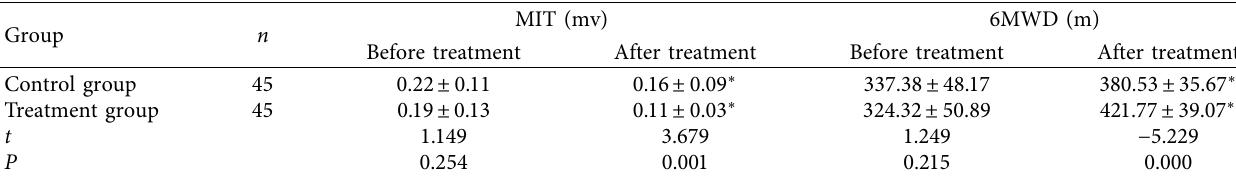
Table 4: Comparison of MIT and 6MWD between the two